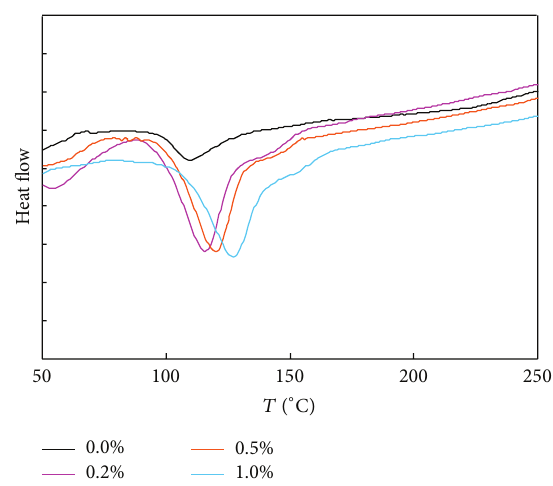
Figure 2: DSC curves of the base material containing varying amounts of